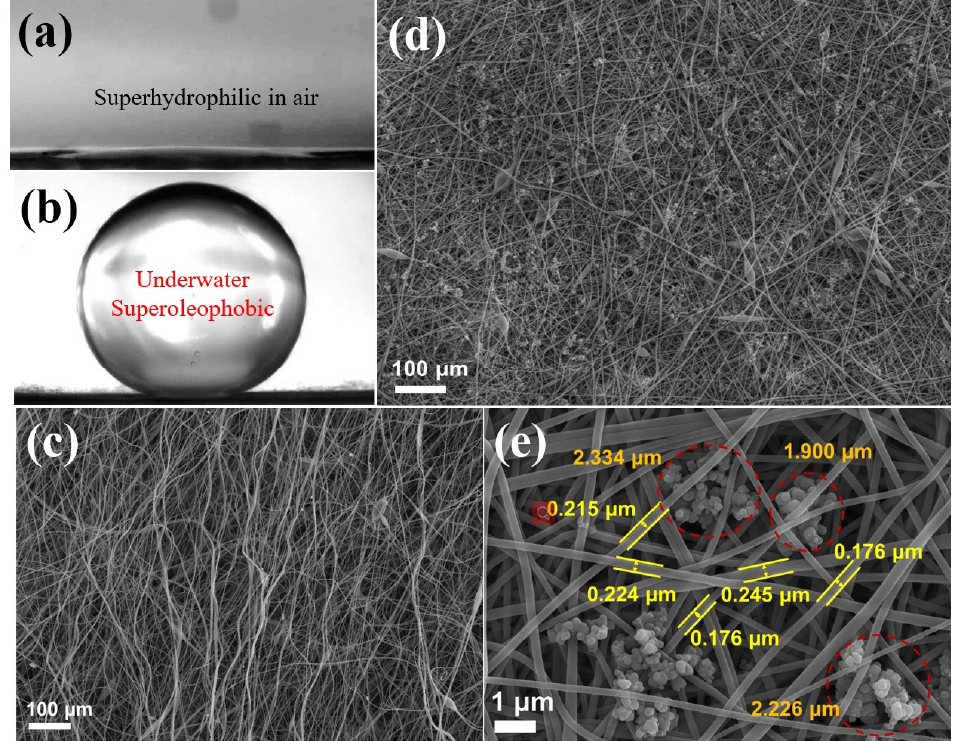
Figure 1. ( a , b ) Illustrations of a water droplet in air and another under water on the surface of H- PDA. ( c ) SEM image of the original PAN nanofiber formed using an SBS process. ( d ) SEM image of the surface of H-PDA. ( e ) Enlarged SEM image of the surface embedded with PDA nanoclus- ters.